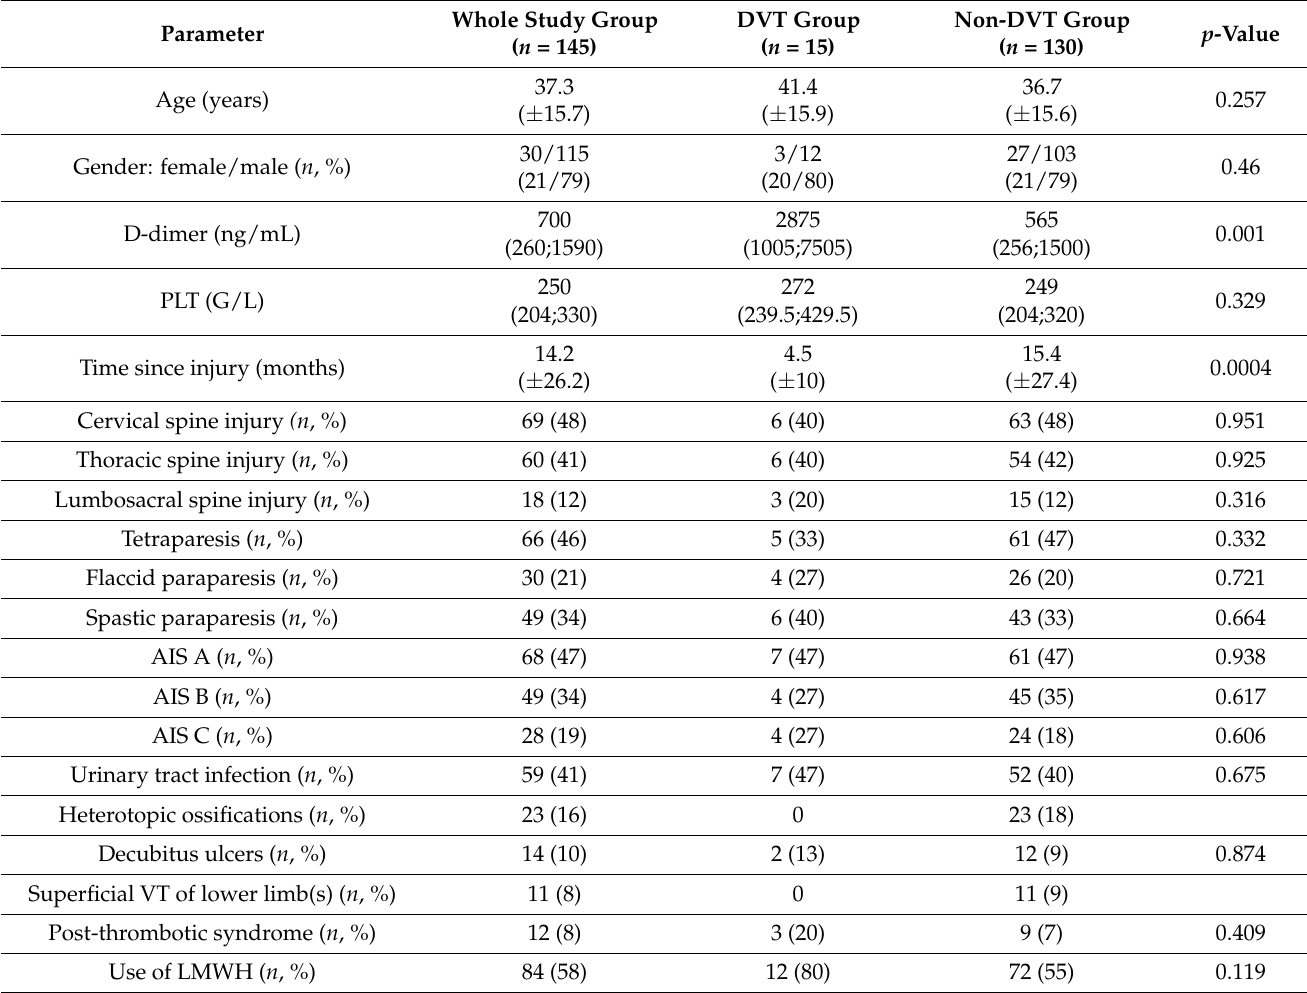
Table 1. Characteristics of whole study group and groups of patients with deep vein thrombosis (DVT group) and without deep vein thrombosis (non-DVT